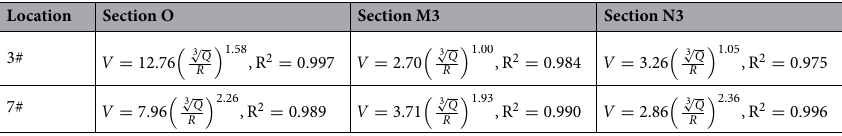
Table 1. PPV fitting formula of measuring points 3# and 7# at different cavern spacing.